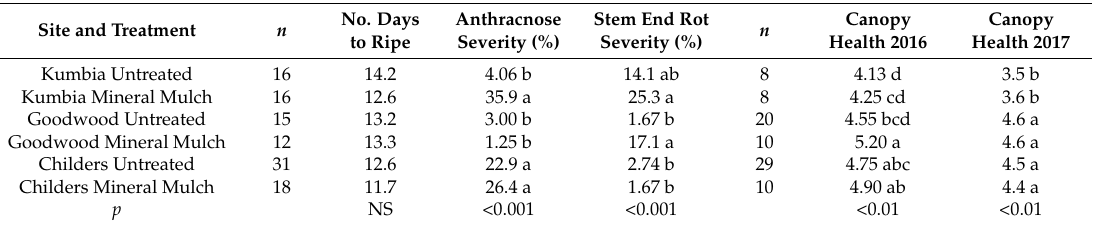
Table 11. Fruit quality and canopy health of avocado 10 months after Mineral Mulch application to trees in three orchards in